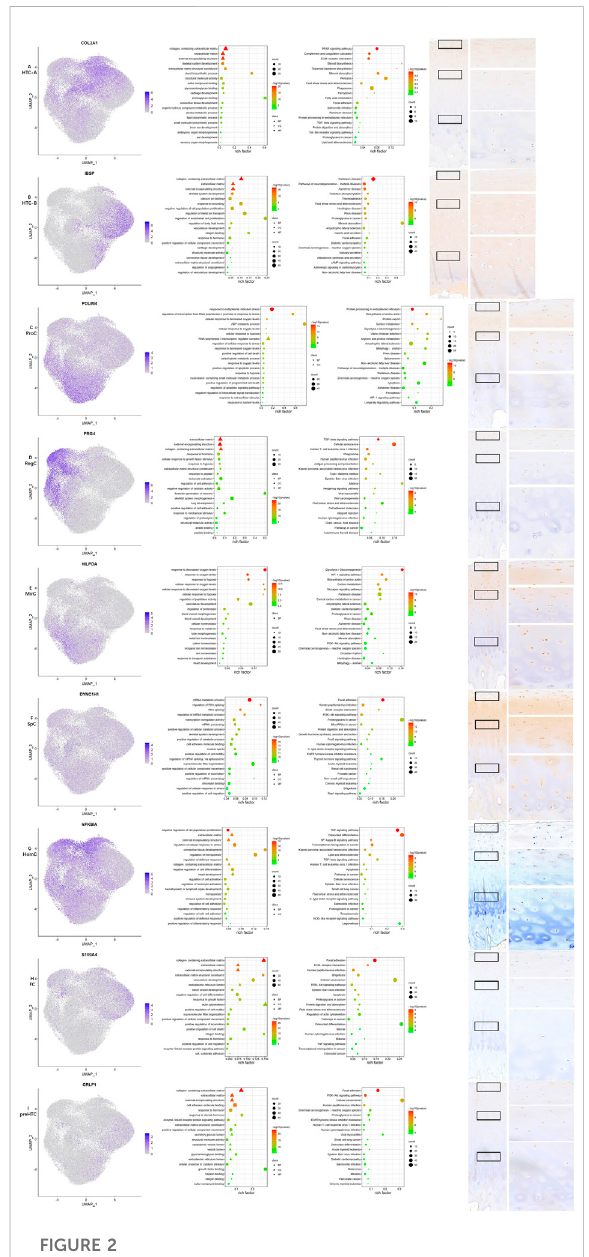
FIGURE 2 Results for speci fi c markers, enrichment analysis and IHC for each cell type. (A – I) From left to right, the scattered plot for speci fi c markers, GO enrichment analysis, KEGG pathway enrichment analysis, and IHC for speci fi c